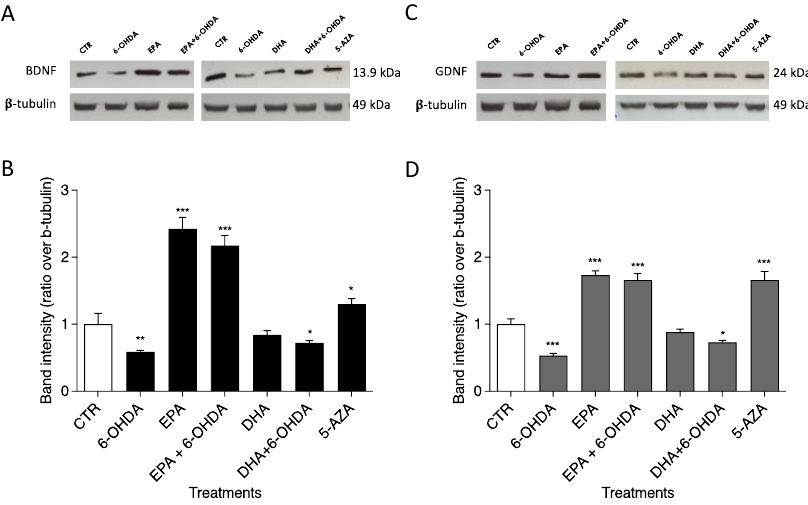
Figure 4. Effects of EPA and DHA alone and in combination with 6-OHDA on protein expression in SH-SY5Y cells. Cells were cultured and treated as reported in M&M. BDNF ( A ) and GDNF ( C ) levels were analyzed by Western blotting. The positions of proteins are indicated in relation to the positions of molecular size standards. β -Tubulin III (neuronal) was used to normalize protein levels. Area density was evaluated by Chemidoc Imagequant TL software. Values of BDNF ( B ) and GDNF ( D ) are expressed relative to the control, which was set to an arbitrary value (1.0). Experimental samples are reported as the mean ± SD. Data from three independent experiments using four independent cultures per condition were analyzed by ANOVA using Graphpad Prism